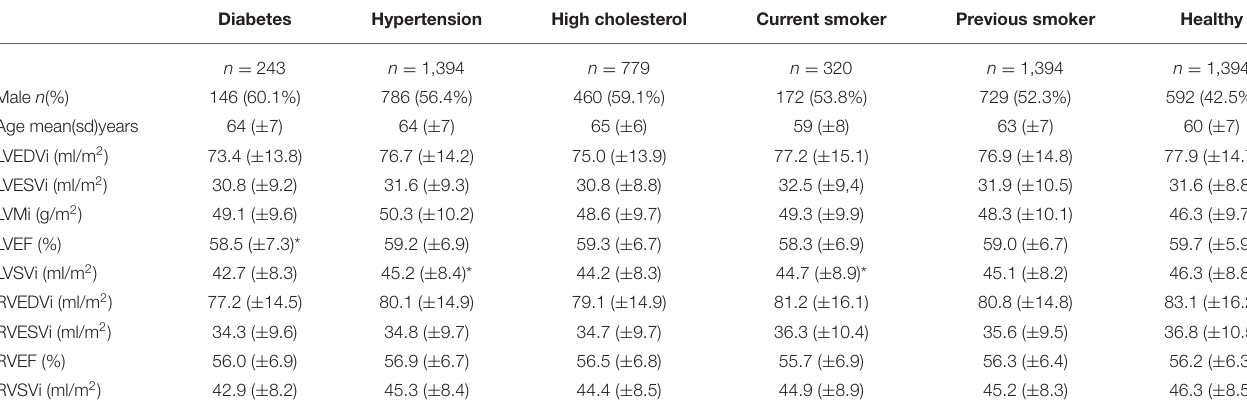
TABLE 1 | Summary of conventional CMR indices for the risk and healthy groups included in the analysis.